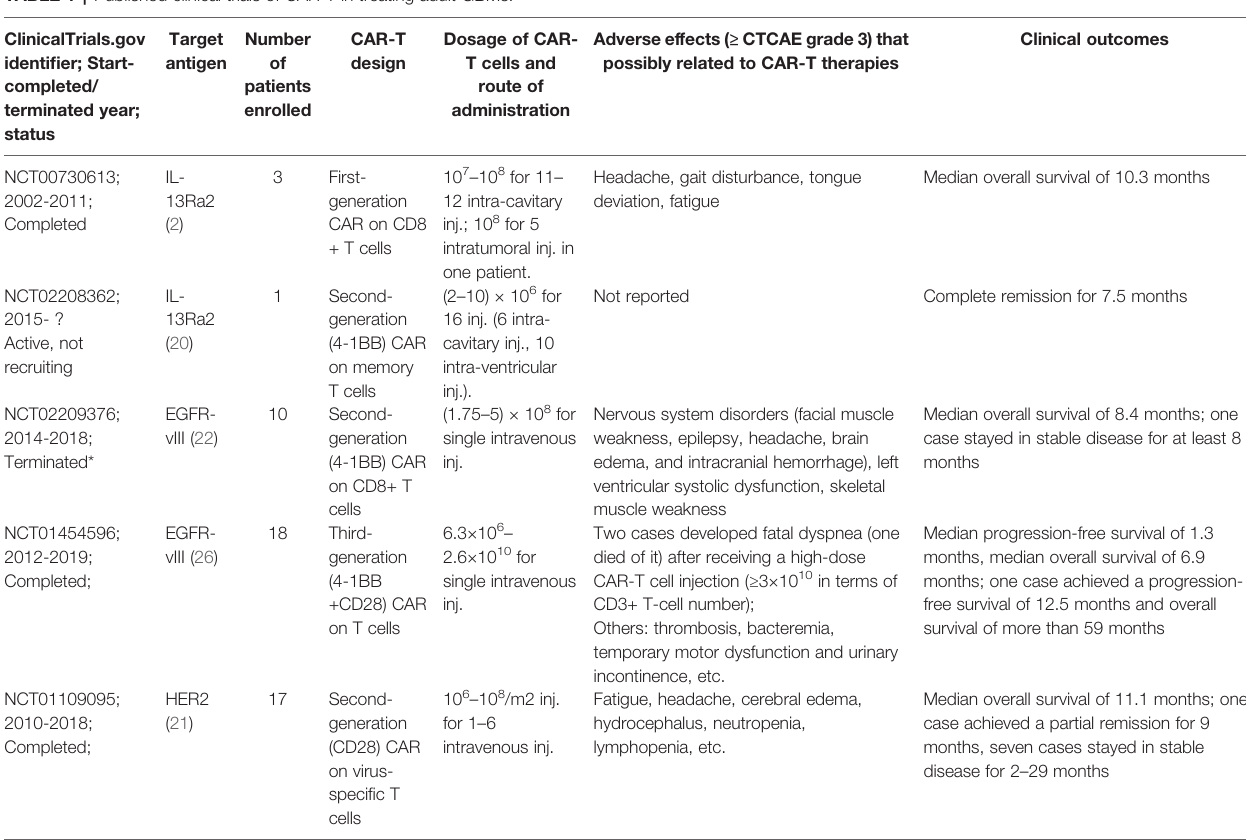
TABLE 1 | Published clinical trials of CAR-T in treating adult